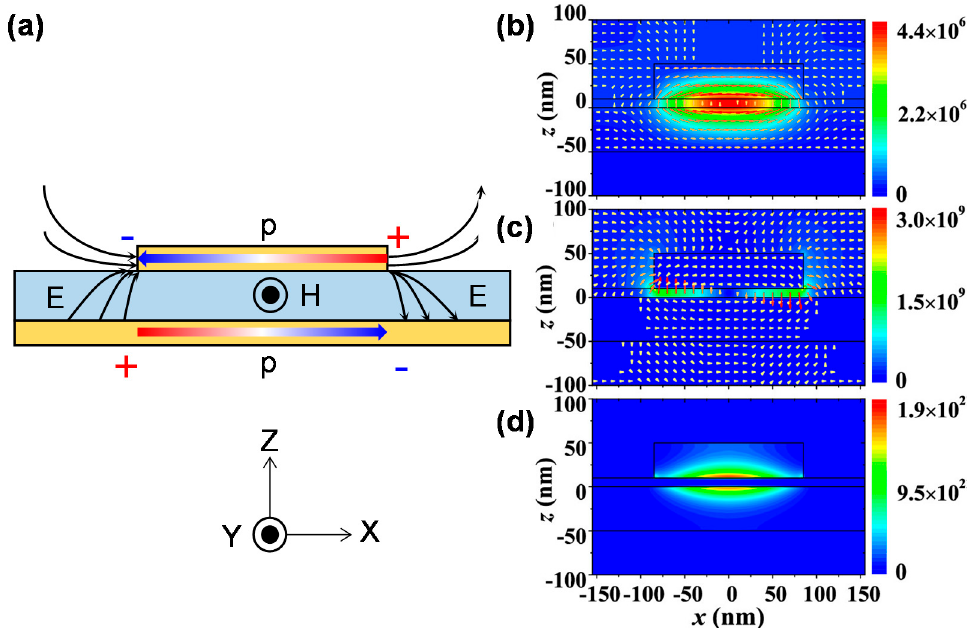
Figure 3. ( a ) Schematic illustration of the operating principle of MIM ‐ PMAs. E, H, and p represent the electric displacement vector, magnetic field, and current, respectively. Calculated results: ( b ) magnetic field; ( c ) electric field; and ( d ) power distribution. The color maps represents the amplitude of each distribution. ( b – d ) are reprinted from Reference [41] with the permission of AIP Publishing.